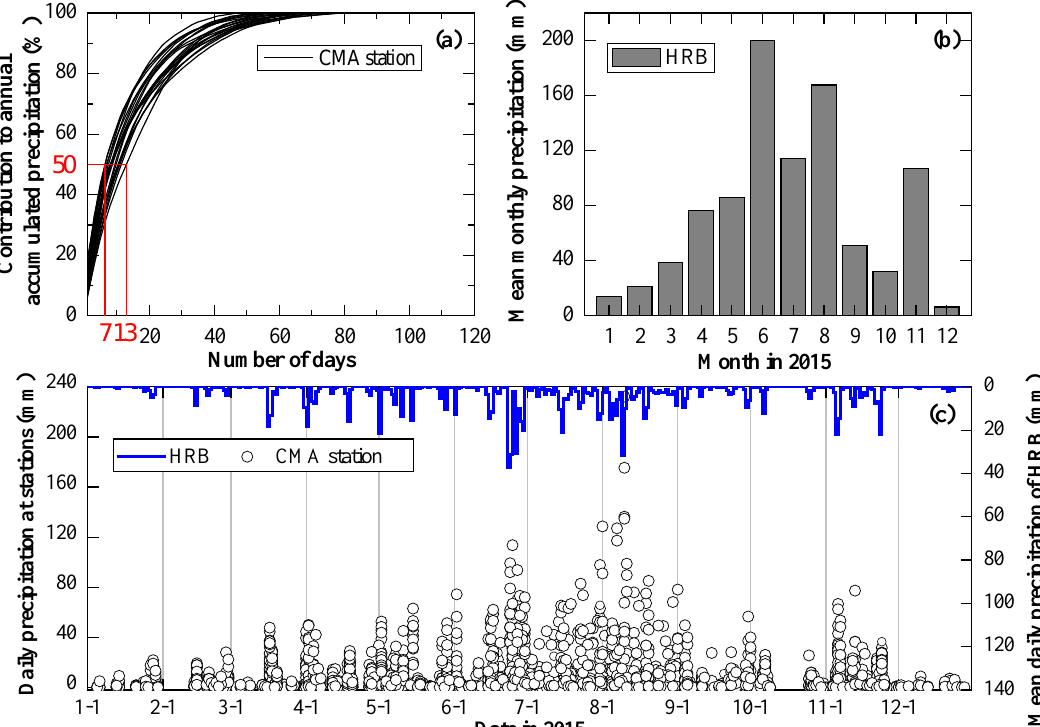
Figure 2. ( a ) Contribution (%) of accumulated daily precipitation to the total annual precipitation for 30 CMA stations across the HRB in 2015 (sorted in decreasing order); ( b ) mean monthly precipitation of the HRB in 2015; ( c ) daily precipitation at the 30 CMA stations and the mean daily precipitation of the basin (HRB).